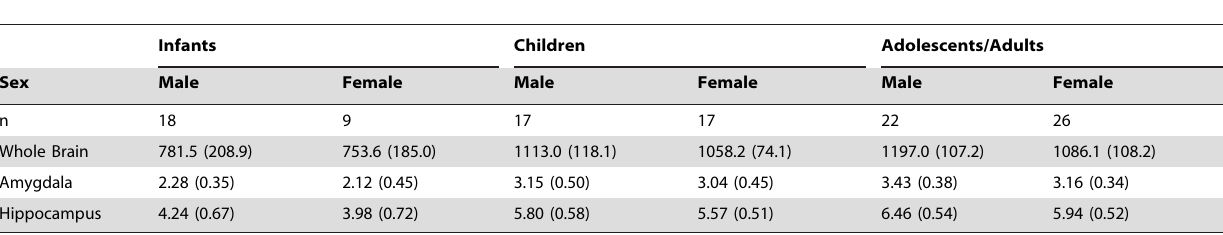
Table 3. Mean volume of whole brain, amygdala and hippocampus (cm 3 ).